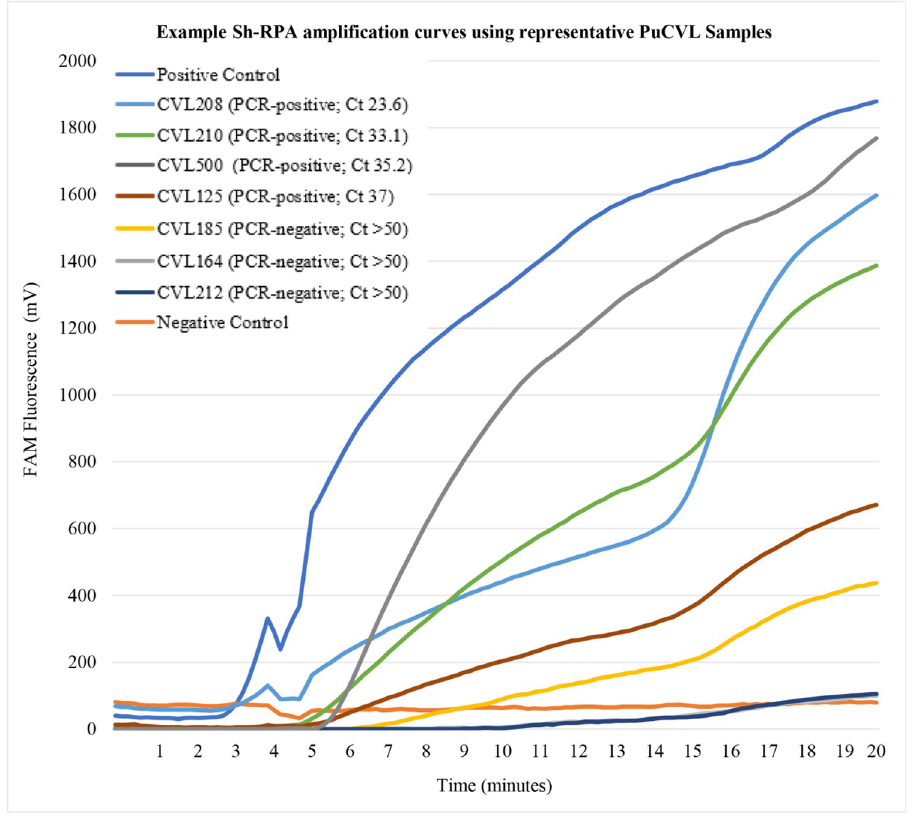
Fig 3. Example Sh-RPA amplification curves using representative PuCVL samples. Three strong and early-onset positive Sh-RPA amplification curves with relatively low associated real-time PCR C t values are shown (samples CVL208, CVL210 and CVL500). One weak but positive Sh-RPA amplification curve with a relatively high associated real-time PCR C t value is shown (CVL125). One weak but positive Sh-RPA amplification curve with an associated real- time PCR C t value of > 50 (and so deemed negative by real-time PCR [40]) is shown (CVL185). Samples CVL164 and CVL212 were deemed negative by both real-time PCR (C t > 50) and Sh-RPA. Neither sample generated a Sh-RPA amplification curve. All real-time PCR C t values were generated during [40].